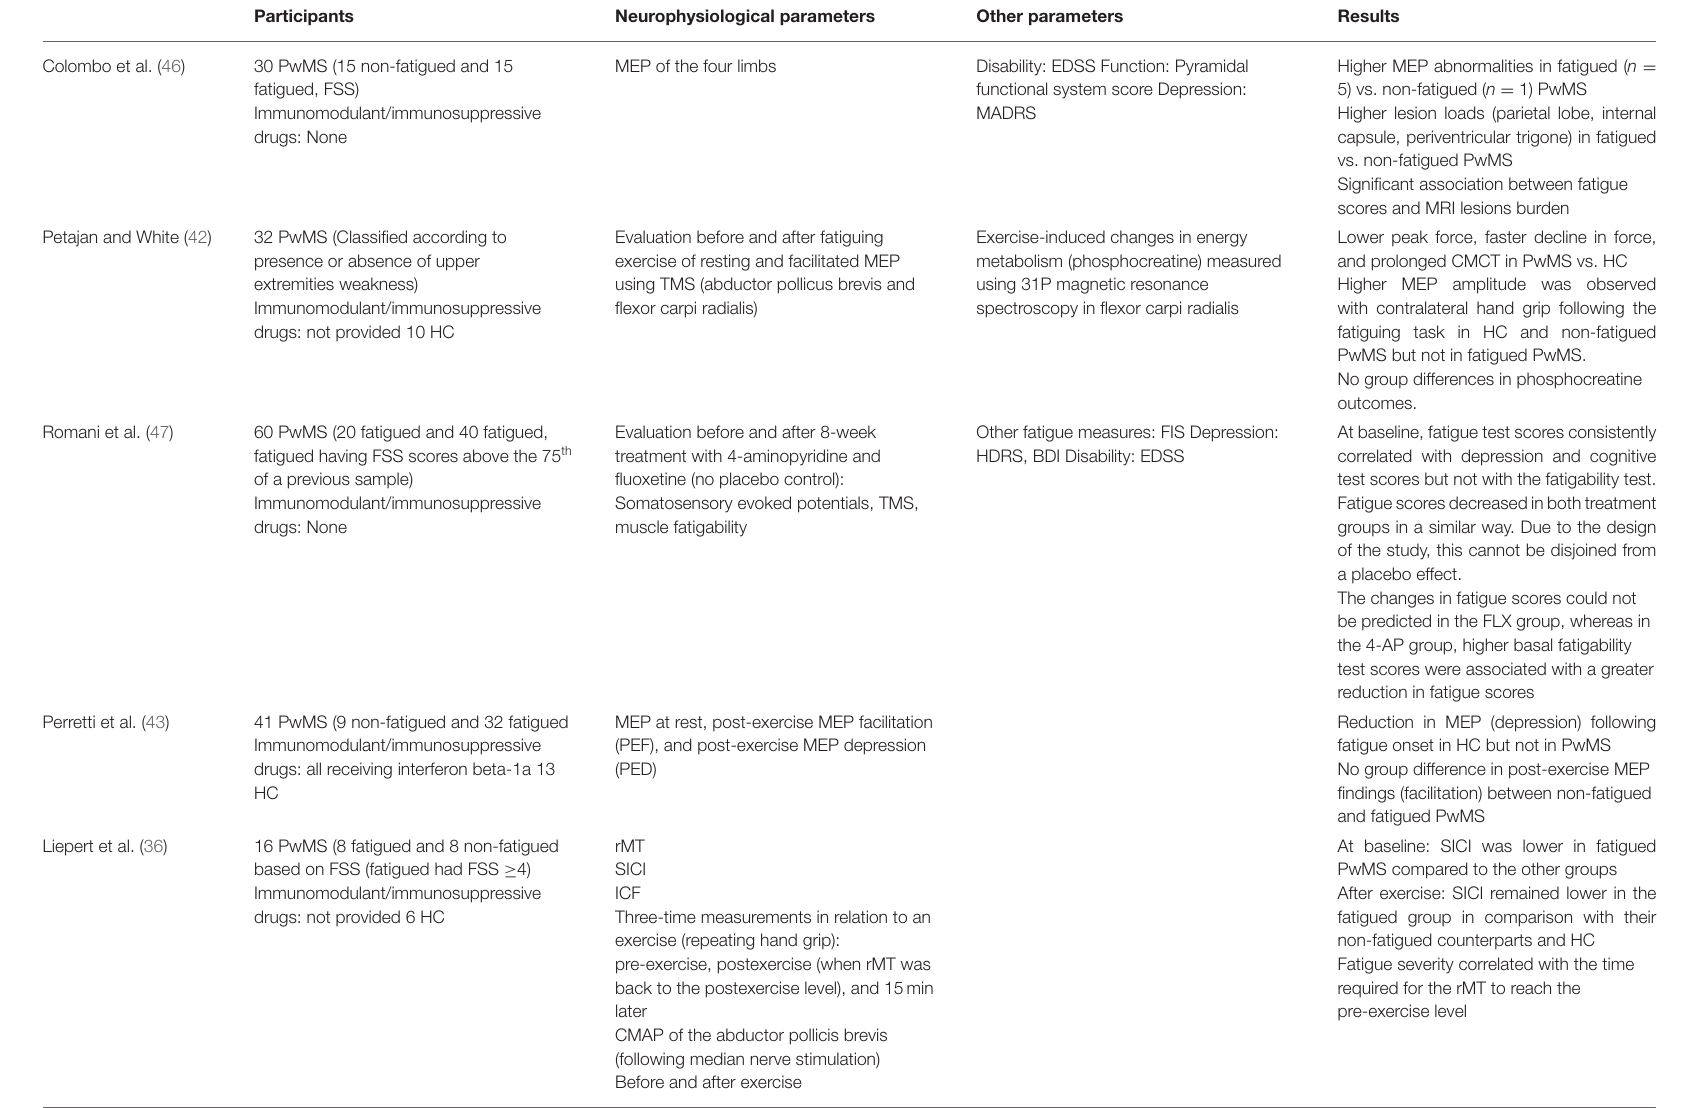
TABLE 1 | Summary of studies on neurophysiological parameters in MS